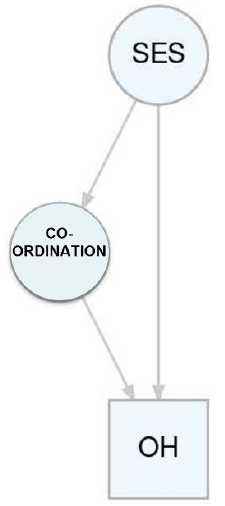
Figure 4. Proportional odds model of oral hygiene and the coordination one-leg-stand test.